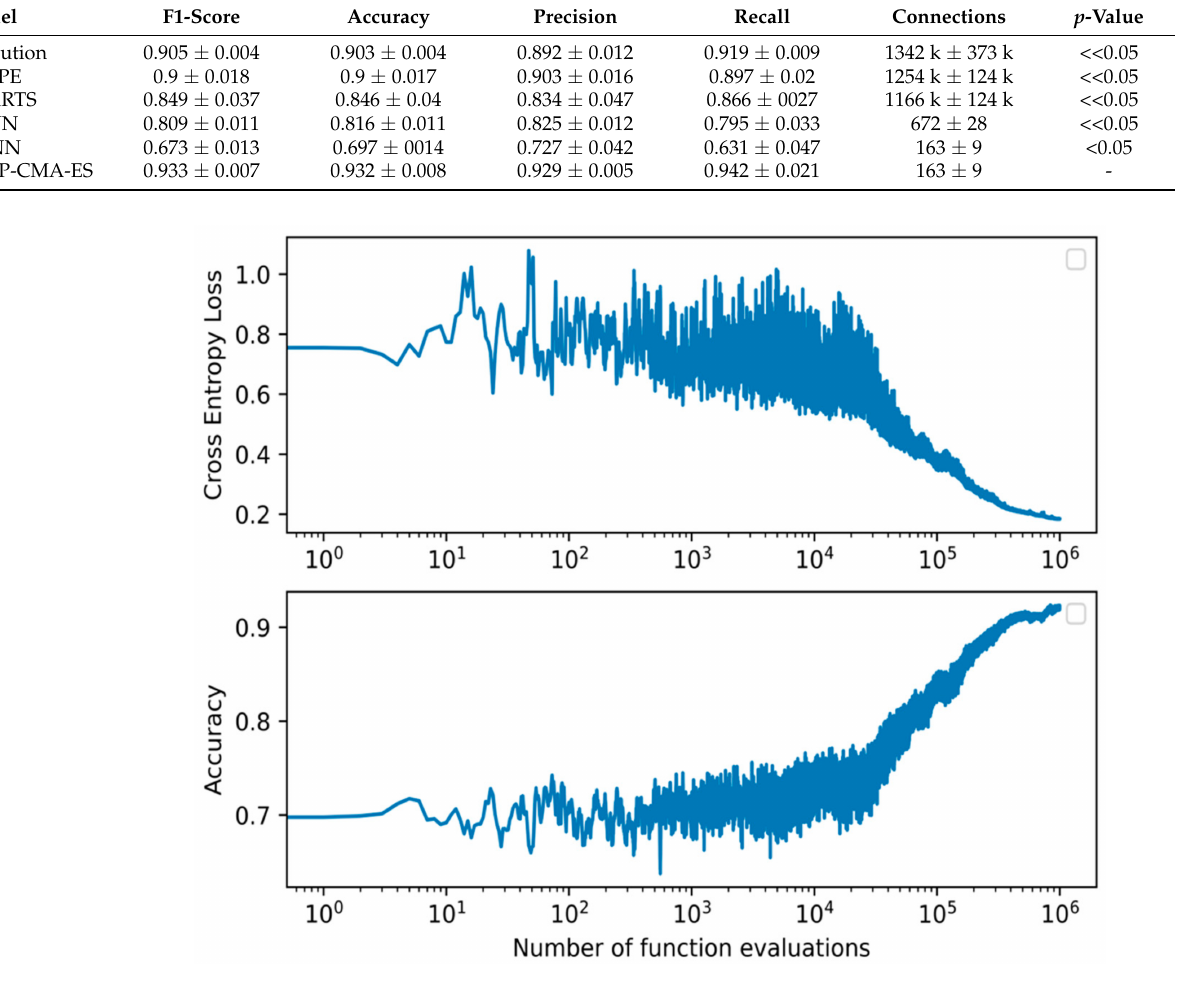
Figure 4. Cross-entropy loss and accuracy curve of the BIPOP-CMA-ES optimization algorithm during training of the best WANN